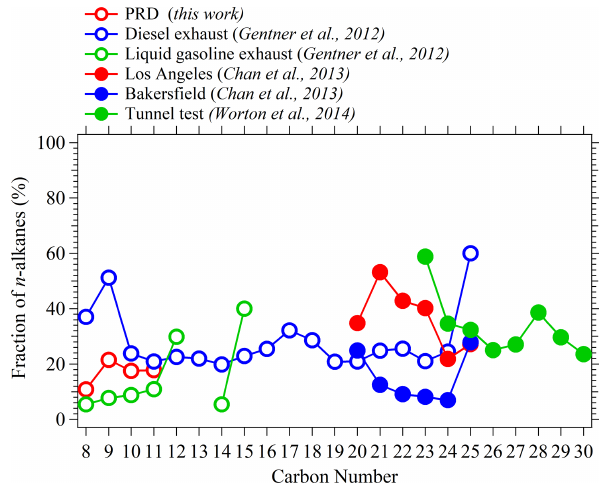
Figure 6. Fractions of n -alkanes in higher alkanes with the same formulas in gas phase (hollow dots) and particle phase (solid dots) derived from this study, ambient air in Los Angeles and Bakersfield, Caldecott Tunnel, and vehicle exhaust (Chan et al., 2013; Gentner et al., 2012; Worton et al.,